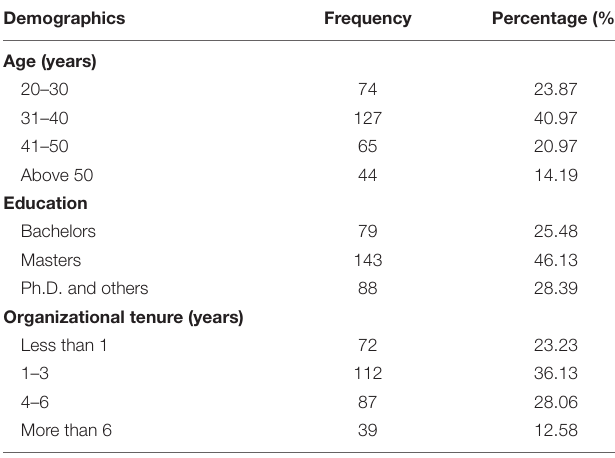
TABLE 1 | Demographic